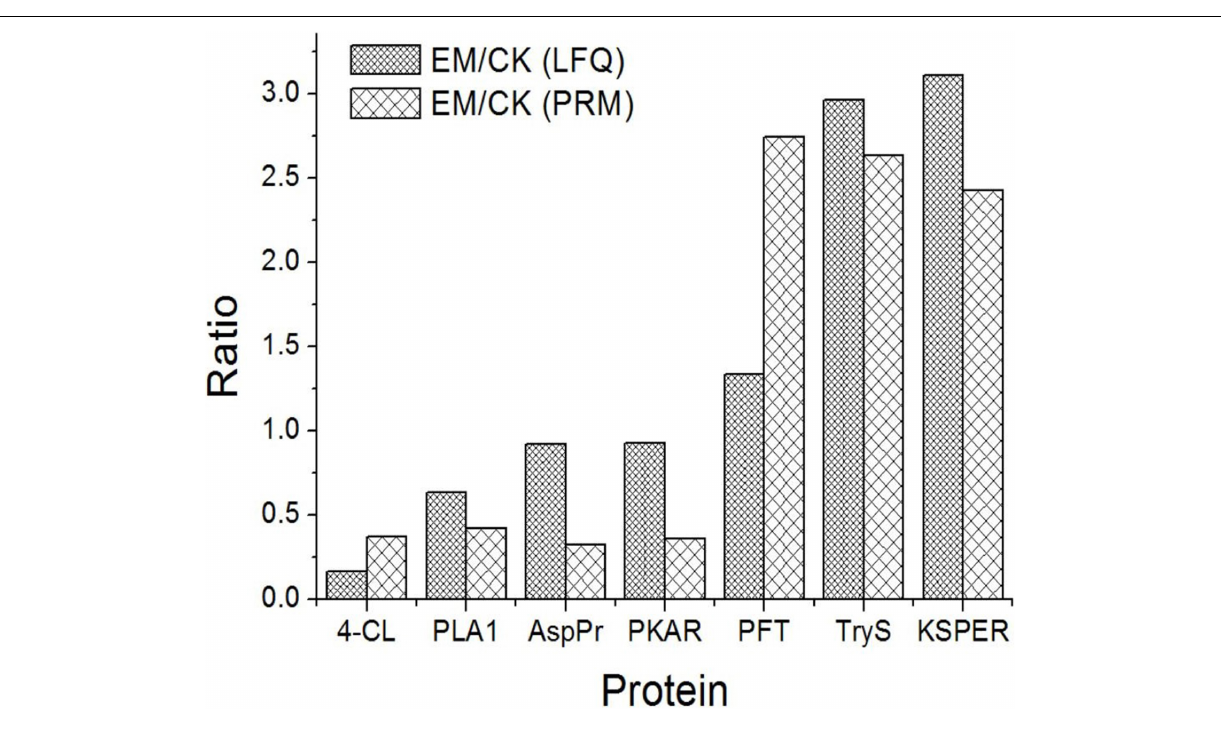
FIGURE 4 | Expression patterns of selected differentially abundance proteins using LFQ analysis and PRM